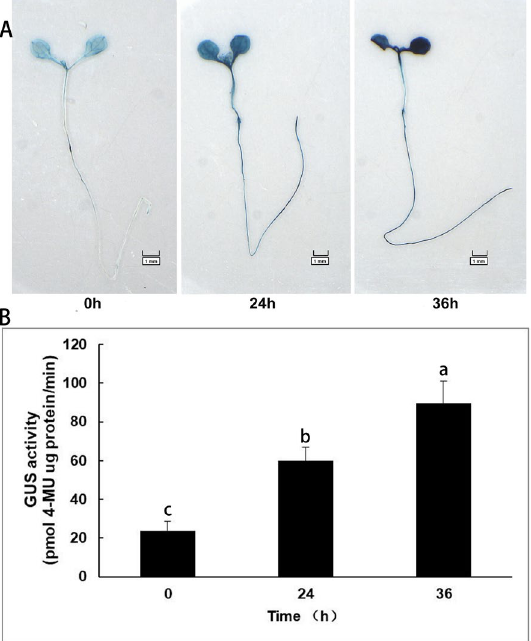
Figure 11. Induction and expression pattern of PebHLH56 under cold stress. ( A ) GUS staining of overexpressing Arabidopsis strains. ( B ) GUS activity quantitative analysis of overexpressing Arabidopsis. Horizontal coordinates indicate different stress treatments, and vertical coordinates represent relative expression values. The different letters mean significance, which was examined by Duncan’s range test ( p <